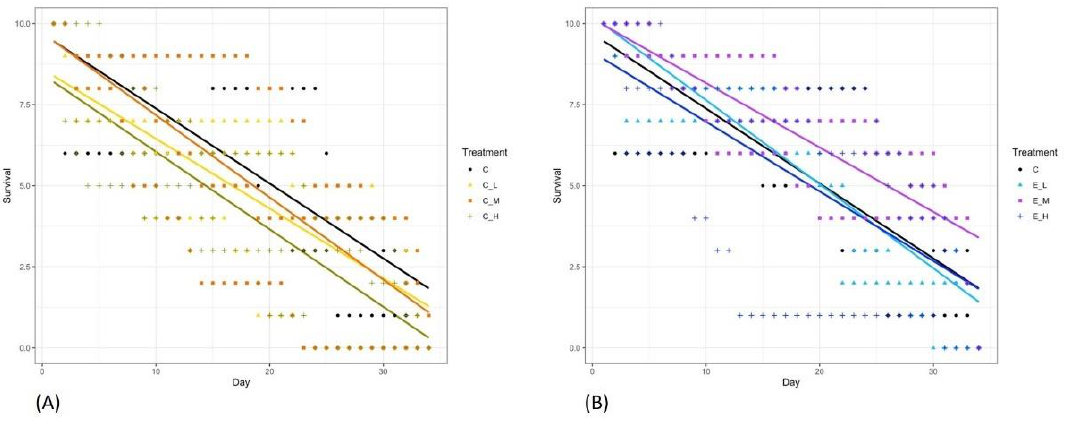
Figure 3. Survival analysis of Nectopsyche sp. related by experiment time with Chlorpyrifos ( A ) and Engeo ( B ). C corresponds to experimental control, C_ corresponds to Chlorpyrifos low (L), middle (M) and high (H) concentrations and E_ corresponds to Engeo low (L) middle (M) and high (H) concentrations.